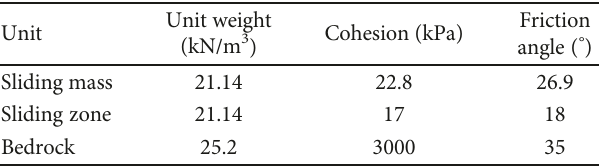
Table 4: Parameters of the landslide material for the stability